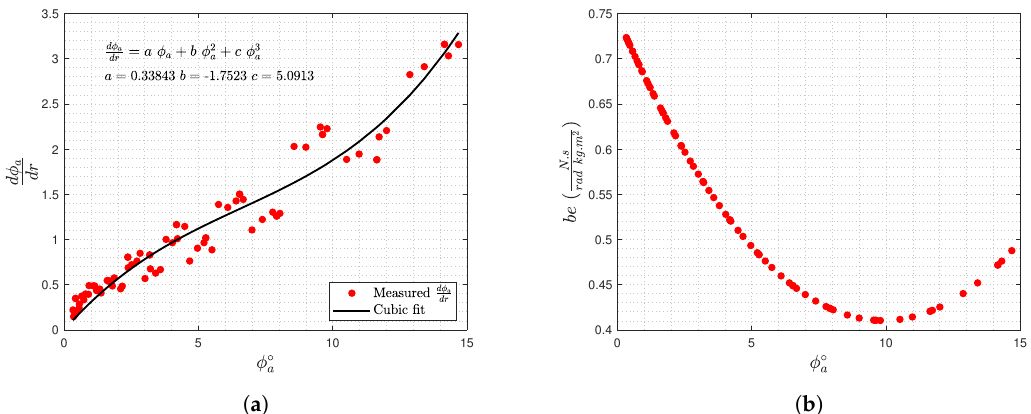
Figure 5. Equivalent linear damping coefficient estimation using Froude energy method with linear, quadratic and cubic damping terms, test case 8 by combining results of 4 tests with different initial roll angles, see Section 3.3. ( a ) Estimation of extinction coefficients a , b and c using cubic curve fitting, Equation (22); ( b ) Equivalent linear damping coefficient be estimation based on the extinction coefficients a , b and c using Equation